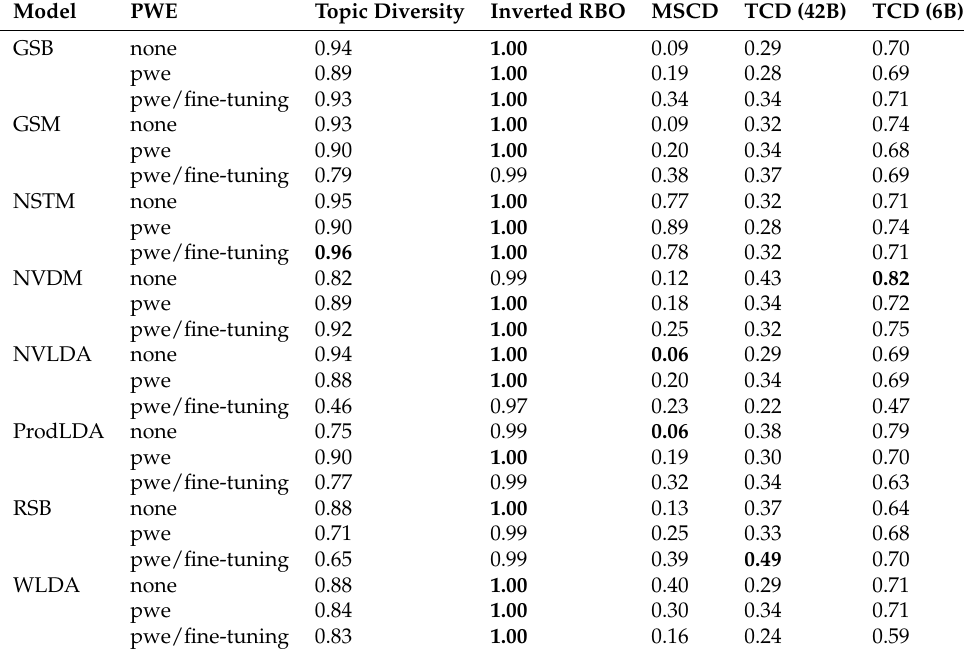
Table 21. Topic Diversity on